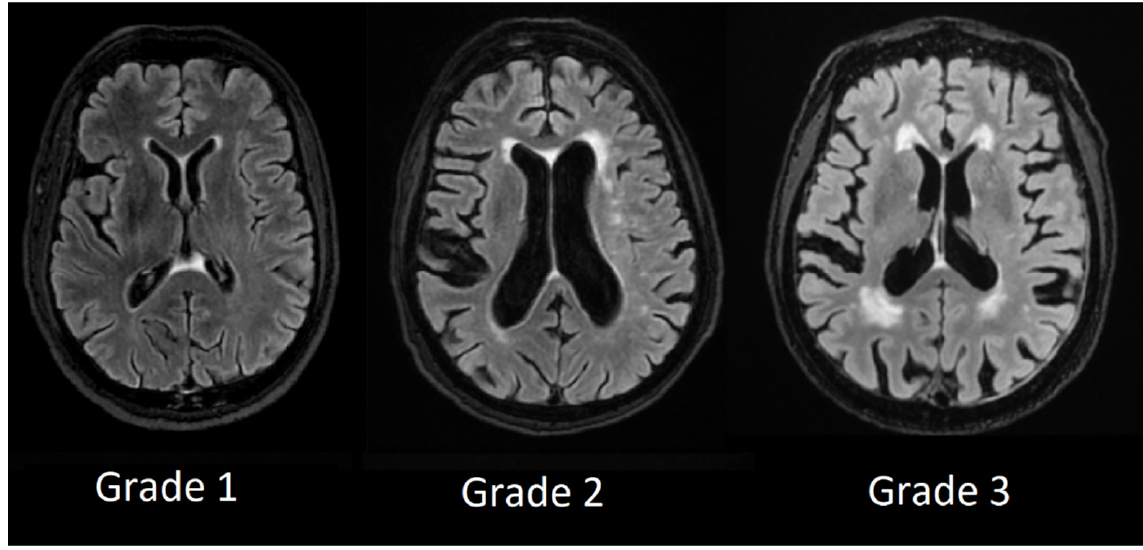
Figure 3. Periventricular white matter hyperintensities based on Fazekas scale from Grade 1 to Grade 3.